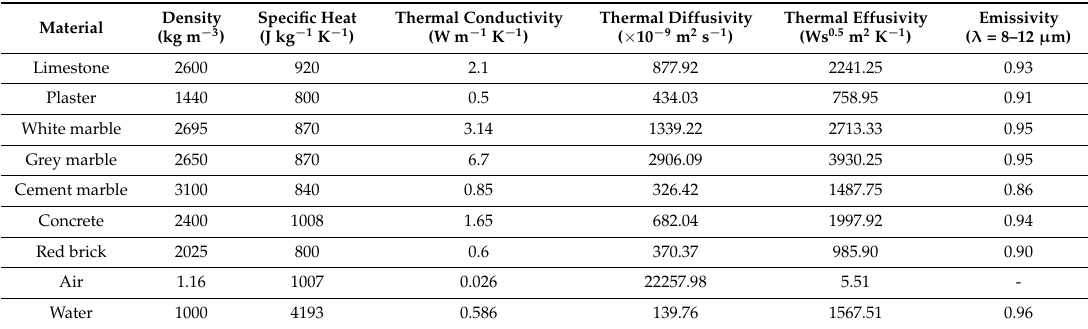
Table 2. Thermo-physical-optical properties of various materials [14].